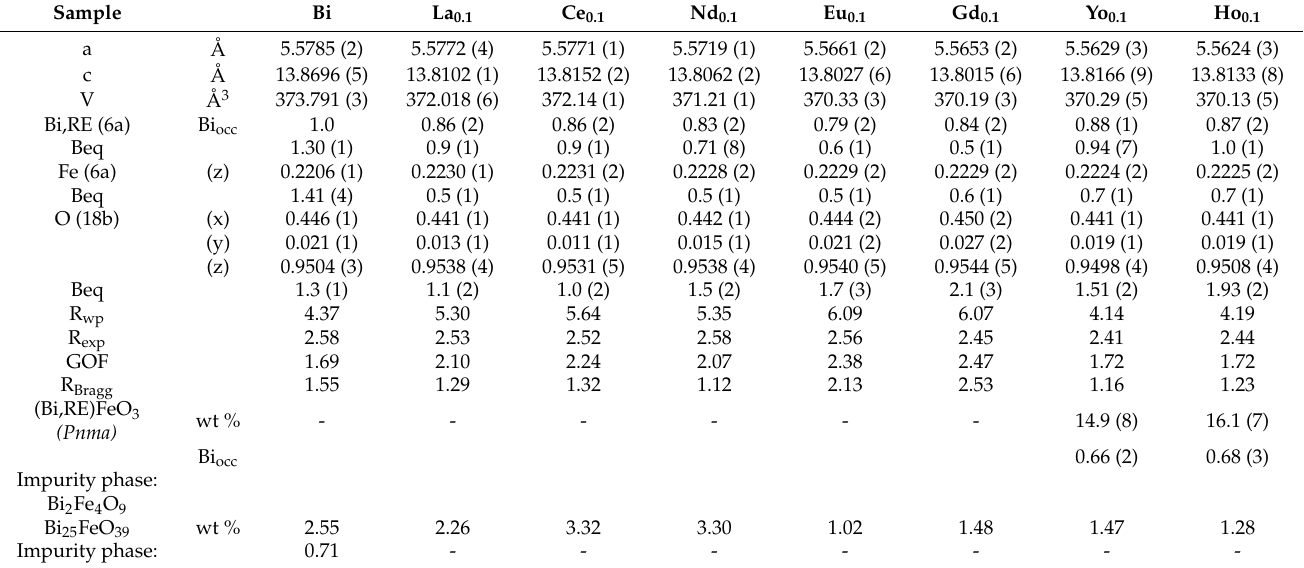
Table 2. Refined structural parameters for BiFeO 3 and substituted Bi 0.9 RE 0.1 FeO 3. The special atomic coordinates are as follows: Bi,RE (0, 0, 0) and Fe (0, 0, z). For the Bi 1 RE 1-x FeO 3 phases that crystallize in SG Pnma, only occupation numbers of A-cation position and weight quantity are listed. The thermal displacement parameters are calculated as Beq = 8 × π 2 × Uiso.